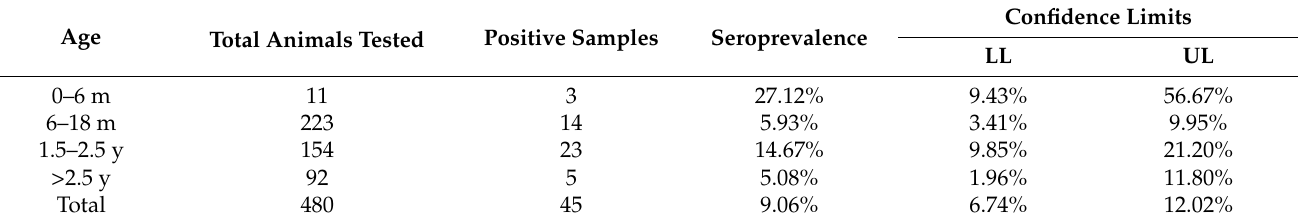
Table 7. Seroprevalence of brucellosis in wild boars stratified by age.